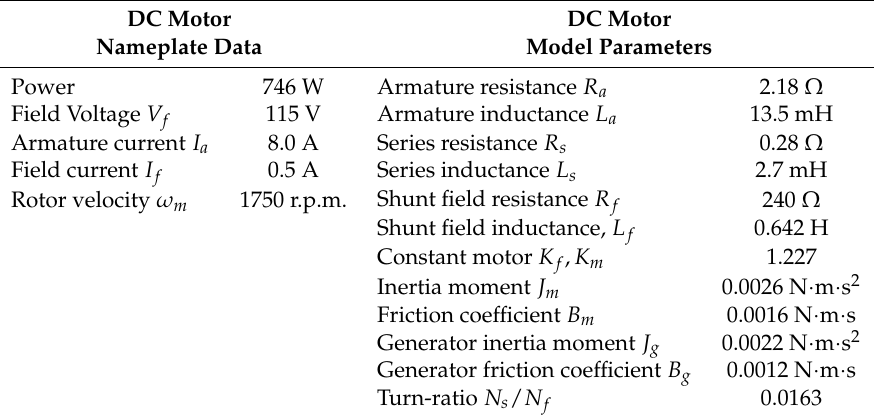
Table 1. DC motor nameplate data and model